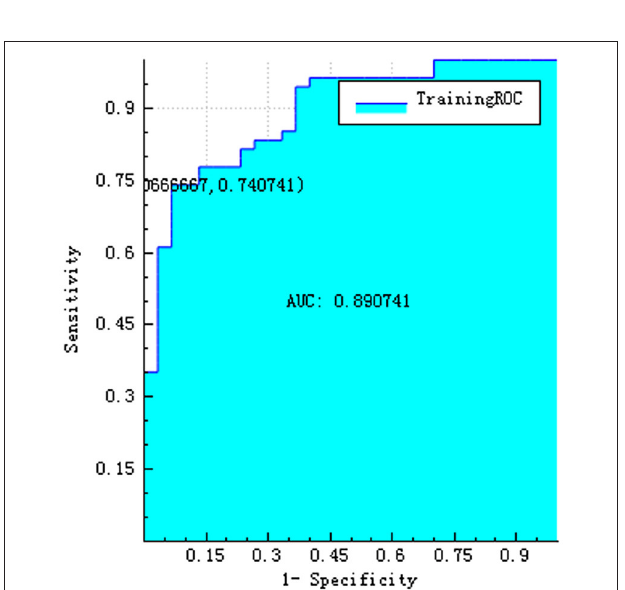
FIGURE 4 | ROC curve of training data.